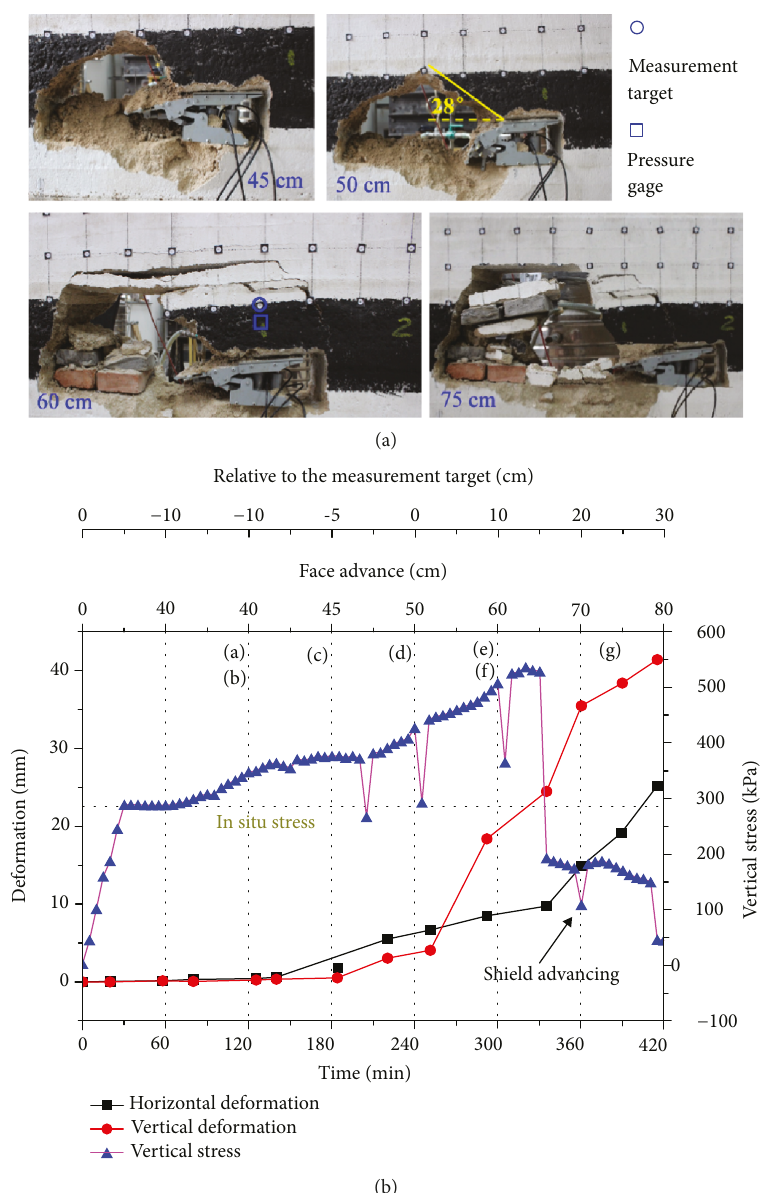
Figure 14: (a) Physical modeling of the whole process of top coal caving and (b) top coal deformation and vertical stress in relation to time and longwall face advancements. The corresponding top coal status in (a) is also